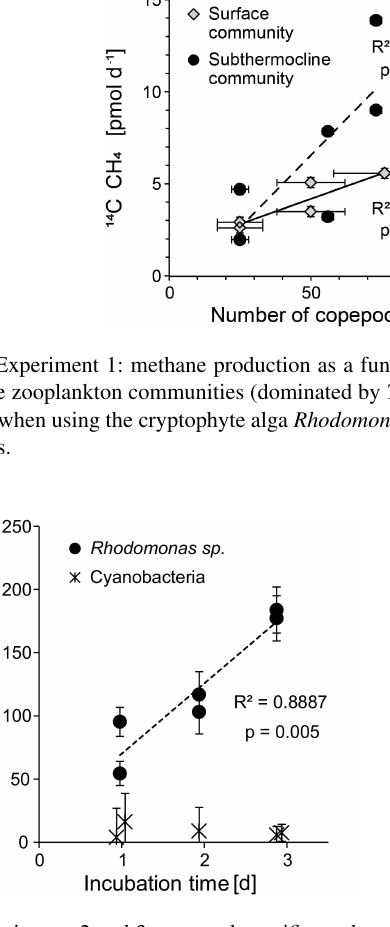
Figure 7. Experiments 2 and 3: copepod-specific methane produc- tion rates over time for the two food sources Rhodomonas sp. and cyanobacterium Nodularia spumigena